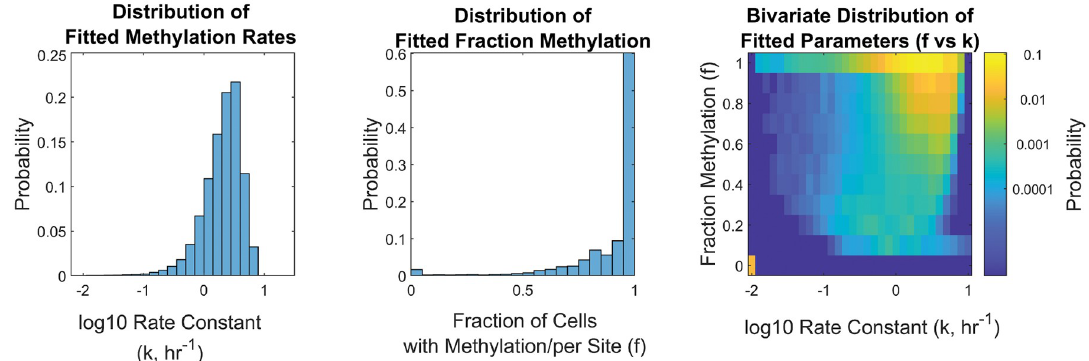
Fig 4. Histogram of inferred remethylation rate k (left), steady-state fraction methylation f (middle), and bivariate heatmap of inferred f vs. k for Chromosome 1 in hESCs (right). Histograms represent * 0.8 million measured CpGs, and are normalized by probability. Note that k -values are only defined for sites with nonzero methylation (i.e., f > 0). In the heatmap, these f = 0 sites are shown in the lower left corner; the position with respect to the k -axis is arbitrary, since they have no defined rate of